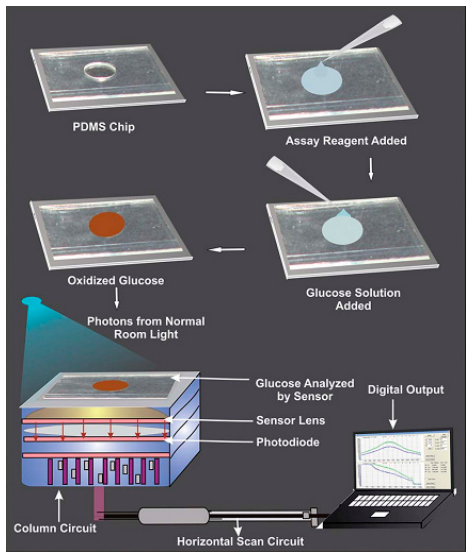
Figure 3. Schematic of PDMS chip utilization for monitoring of glucose solutions by a CMOS image sensor. Reprinted with permission from [44].